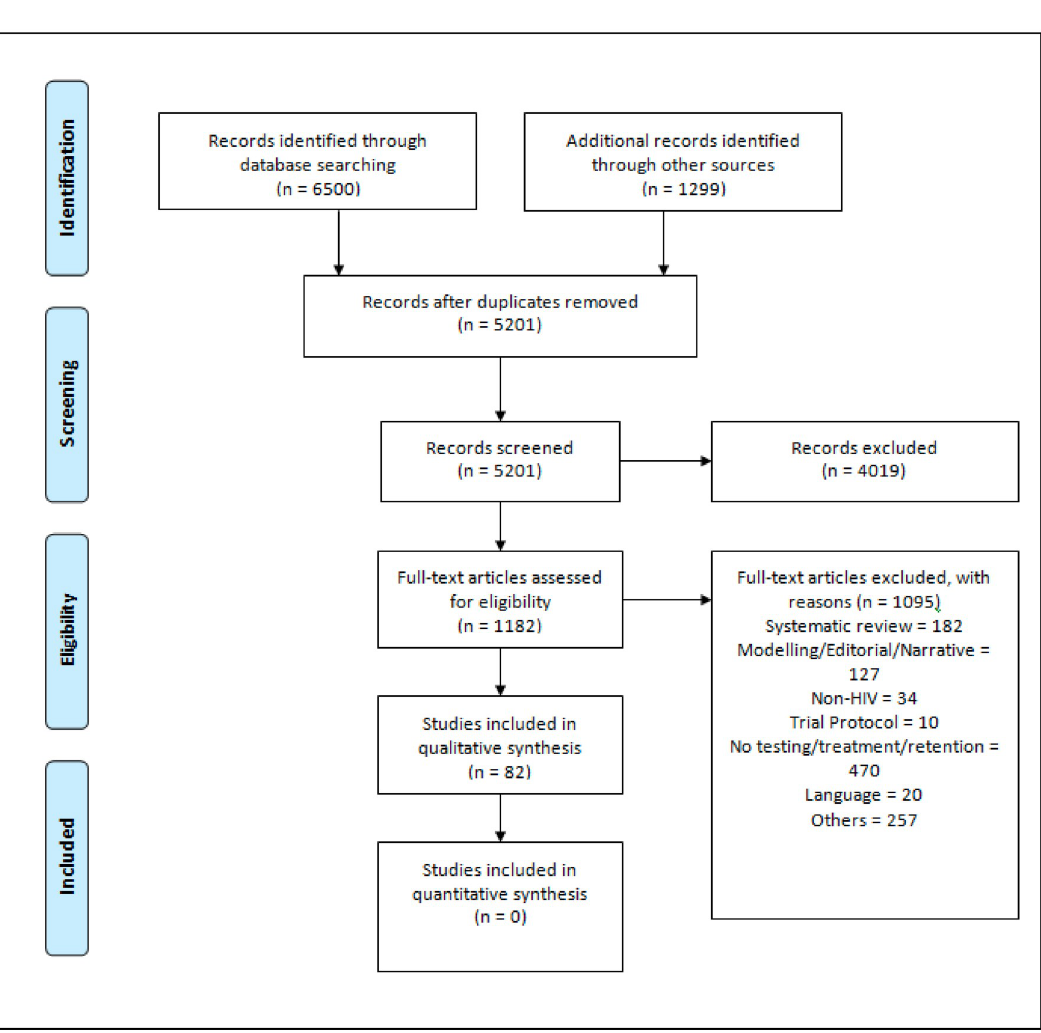
Fig 1. Preferred reporting items for systematic reviews and meta-analyses (PRISMA) Flow